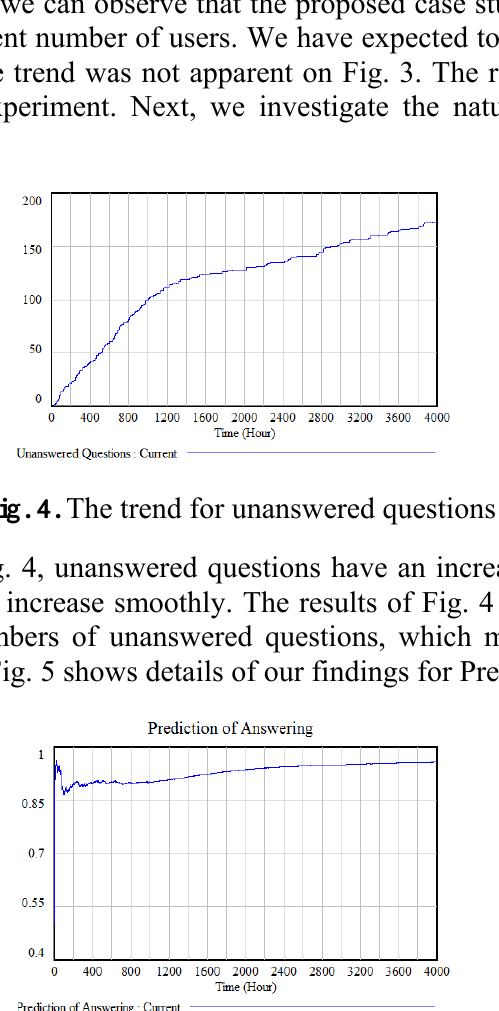
Fig. 5. Prediction of